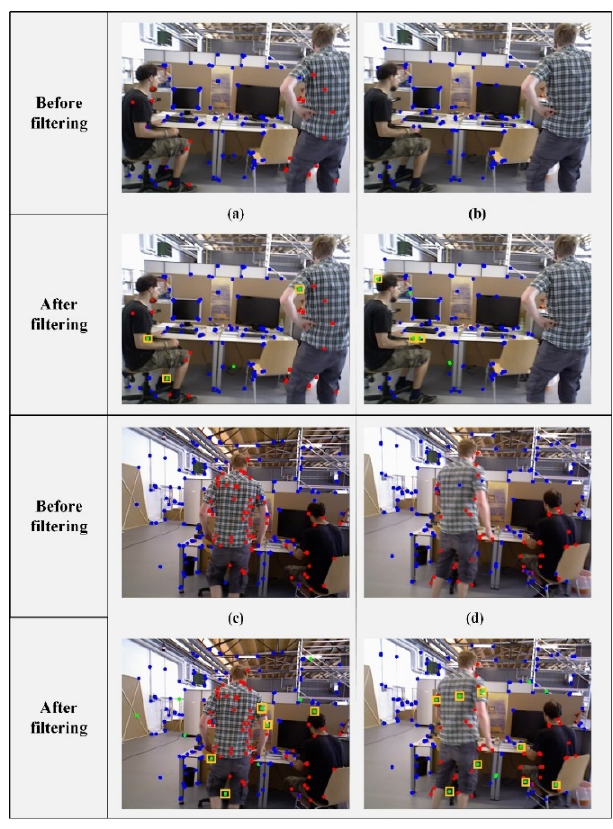
Figure 8. Further comparison of filtering performance. In the figure, ( a , b ) are two adjacent frames. ( c , d ) are randomly extracted frames. Red points represent the projections of dynamic map points. Blue points represent the projections of static map points. Green points are the projections of filtered map points in the second round. The points selected in the yellow rectangular box correspond to the green points in the a priori dynamic region.